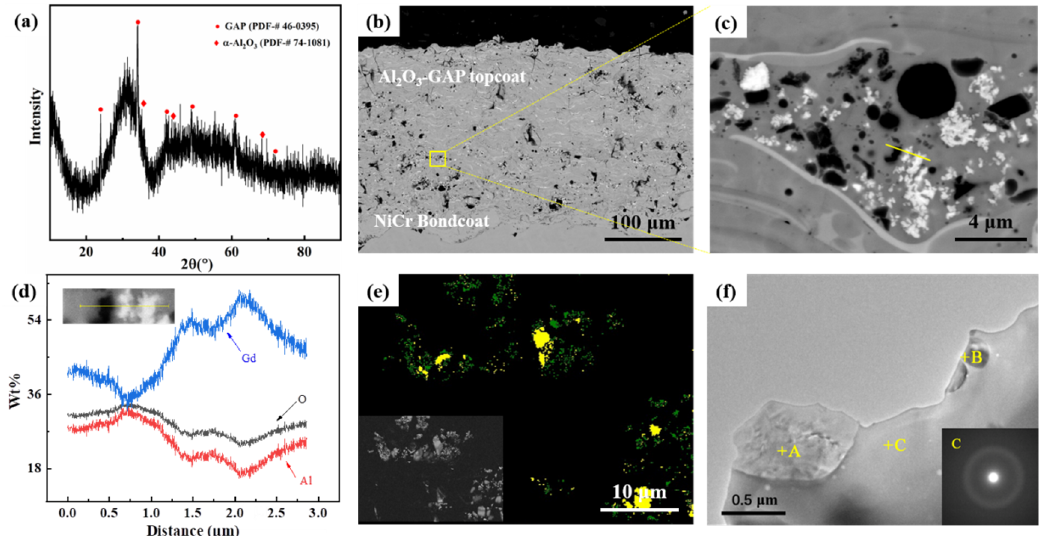
Figure 2. ( a ) XRD pattern of as-sprayed Al 2 O 3 -GAP coating; ( b ), ( c ) cross-sectional SEM images of Al 2 O 3 -GAP coating; ( d ) the zoomed morphology image of the Al 2 O 3 -GAP coating and line scan from image ( c ); ( e ) electron backscattered diffraction ( EBSD ) images of the Al 2 O 3 -GAP amorphous coating; ( f ) TEM image of as-sprayed Al 2 O 3 -GAP coating and selected area electron diffraction (SAED) pattern corresponding to zone C.